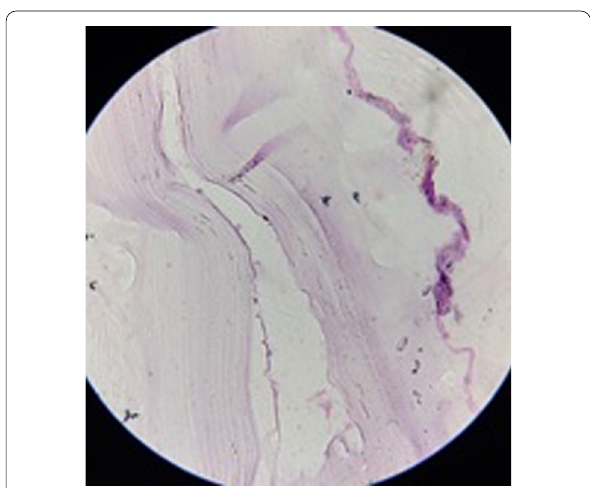
Fig. 4 Low-magnification photomicrograph showing lamellated fibrous and chitinous wall and inner germinal lining of hydatid